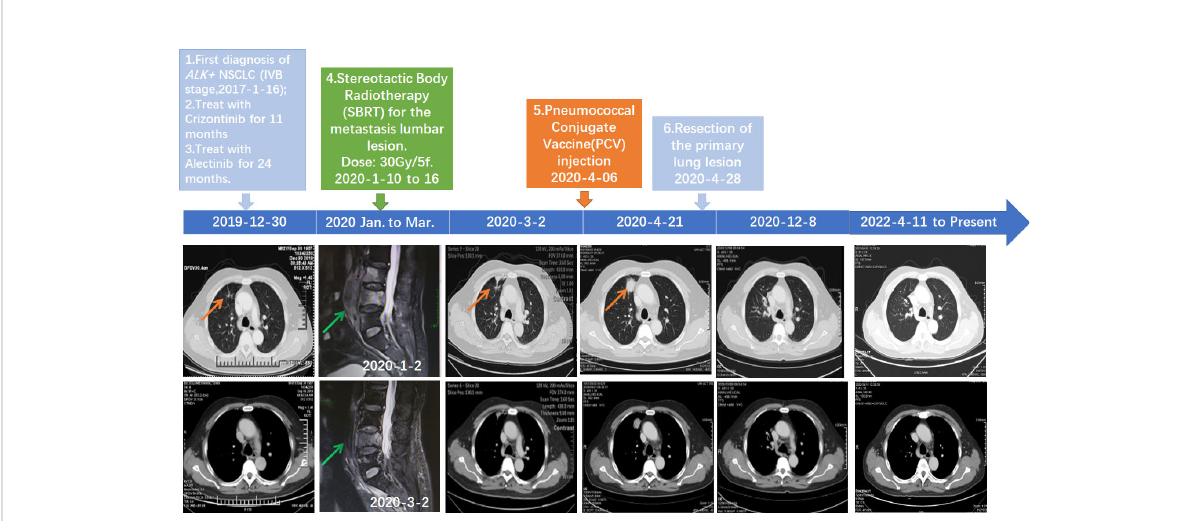
FIGURE 1 Schematics timeline showing the patient treatment history. The computed tomography (CT) and magnetic resonance imaging (MRI) scan at different clinical time points as shown. Red arrows: location of the primary lung lesion in different scans. Green arrow: location of the metastasis lumbar lesion in different